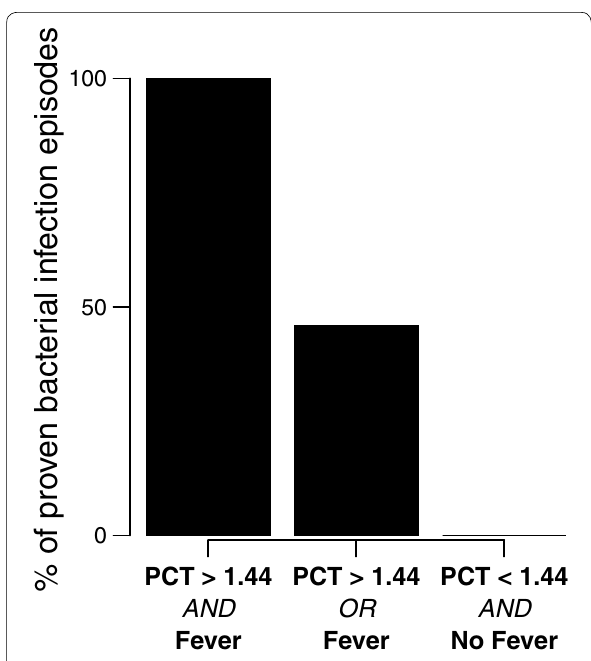
Fig. 3 Procalcitonin (PCT) and fever as markers of proven bacterial infection at admission. Results are shown in percent of episode with proven bacterial infection over total episode presenting both (100%), either one (46%) or none (0%) of PCT >1.44 ng/mL and fever. PCT is expressed in ng/mL. Fever is retained in case of temperature > 38